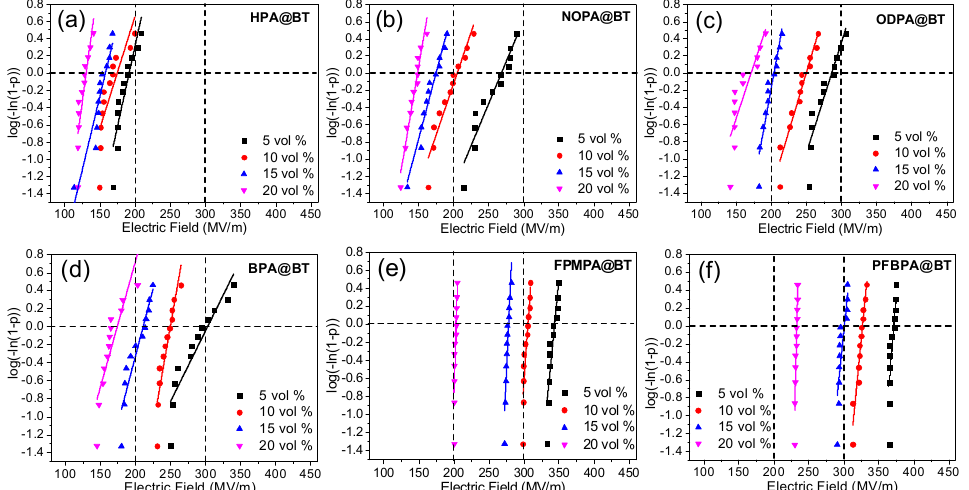
Figure 6. Weibull plots for the breakdown strength of the P(VDF-HFP) nanocomposites with different volume fractions of functionalized BT nanoparticles ( a – f